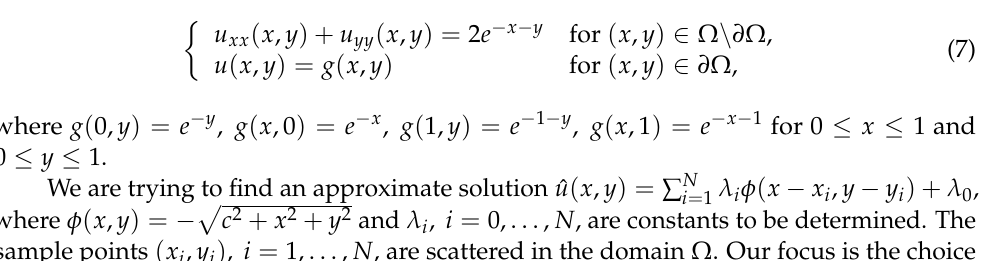
Table 2. 2D experiment, c = 17, b 0 =